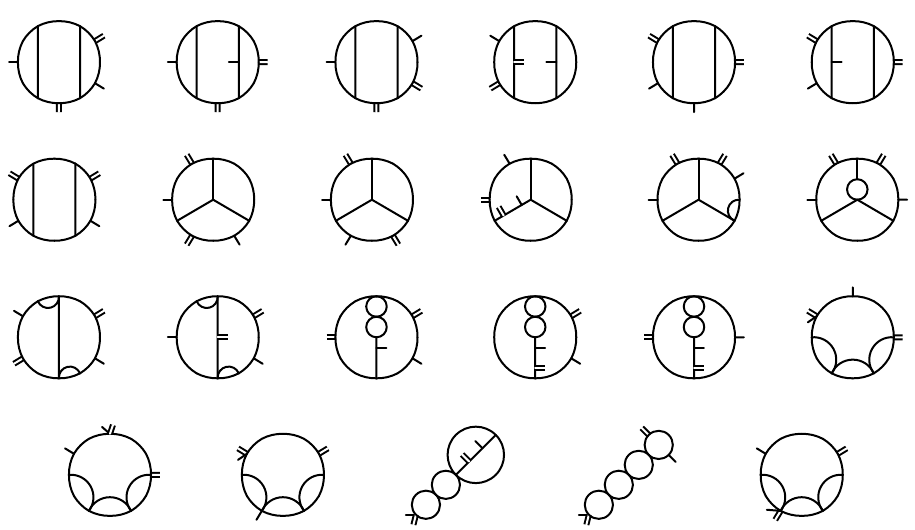
Figure 2 . Three- and four-loop propagator topologies used for the reduction to master integrals and the expansion in ω using differential equations. The external double line represent the off-shell photon while the simple lines the parton. Each diagram allows for two independent flows of the external momenta resulting in the same topology up to a sign inversion ω ↔ − ω . Series expansion and differential